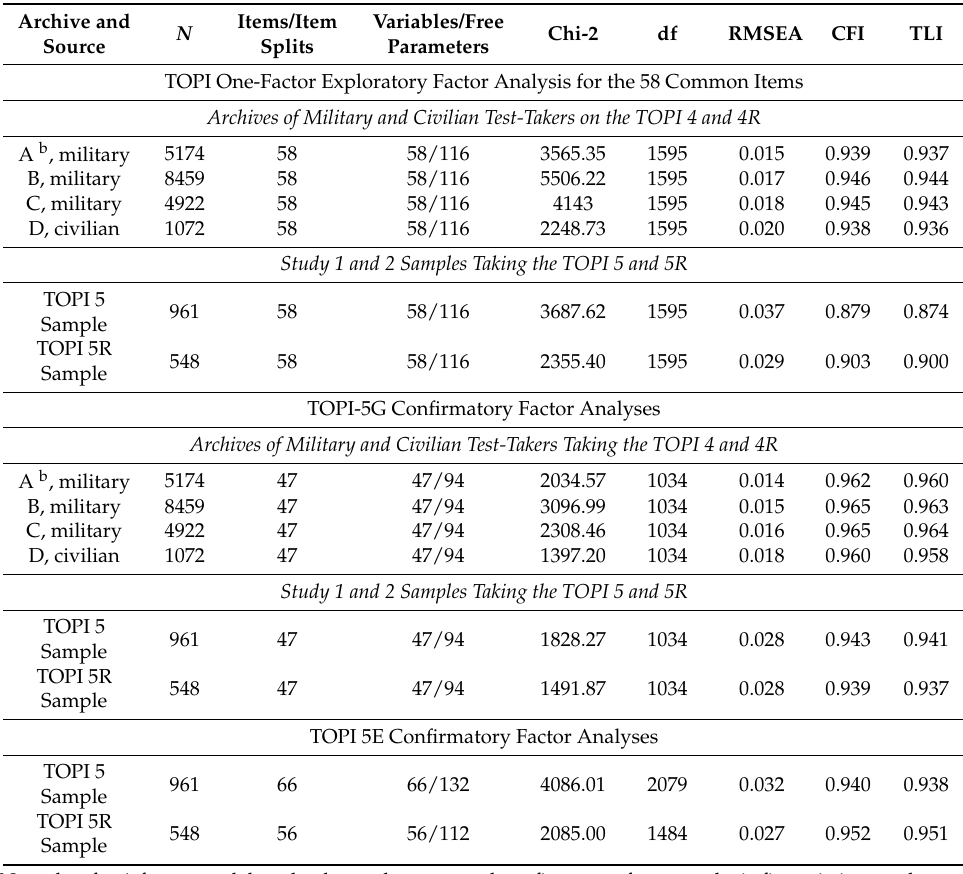
Table 3. The Study 3 model fits of the factor analyses a of the one-factor models of the TOPI 5G and 5E across relevant archives and